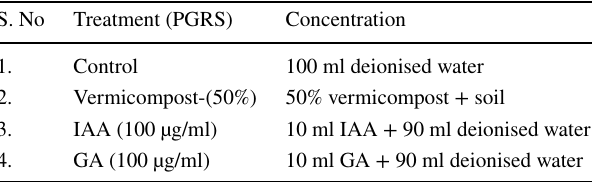
Table 1 Showing the vermicompost and various plant growth